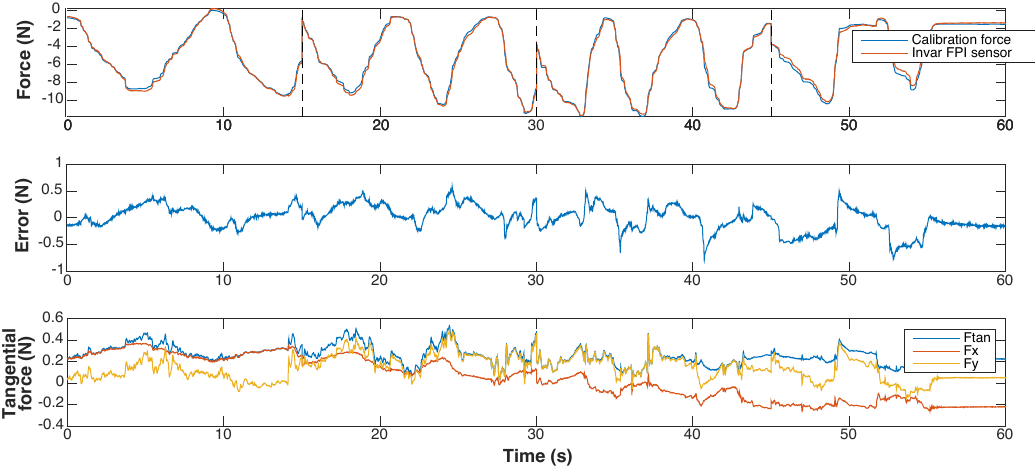
Figure 13. Results of dynamic calibration of a prototype of the Invar capillary concept at room temperature shown as function of time. The graphs present, from top to bottom: (1) the calibration force and the force measured with the prototype, calculated using the interpolation function shown in Figure 12; (2) the measurement error of the prototype; (3) the transverse force on the needle tip, shown as the resultant transverse force (Ftan) and its two orthogonal components (Fx and Fy). The dotted lines in the top graph (1) indicate the 15 s long fragments of which the dataset obtained during dynamic calibration is